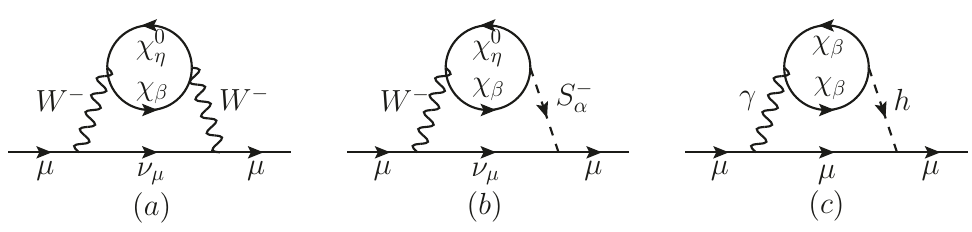
Figure 2 . The main two-loop rainbow diagram (a) and Barr-Zee type diagrams (b,c) in which a closed fermion loop is attached to the virtual gauge bosons or Higgs (cid:12)elds, the corresponding contributions to the muon MDM are obtained by attaching a photon on all possible ways to the internal